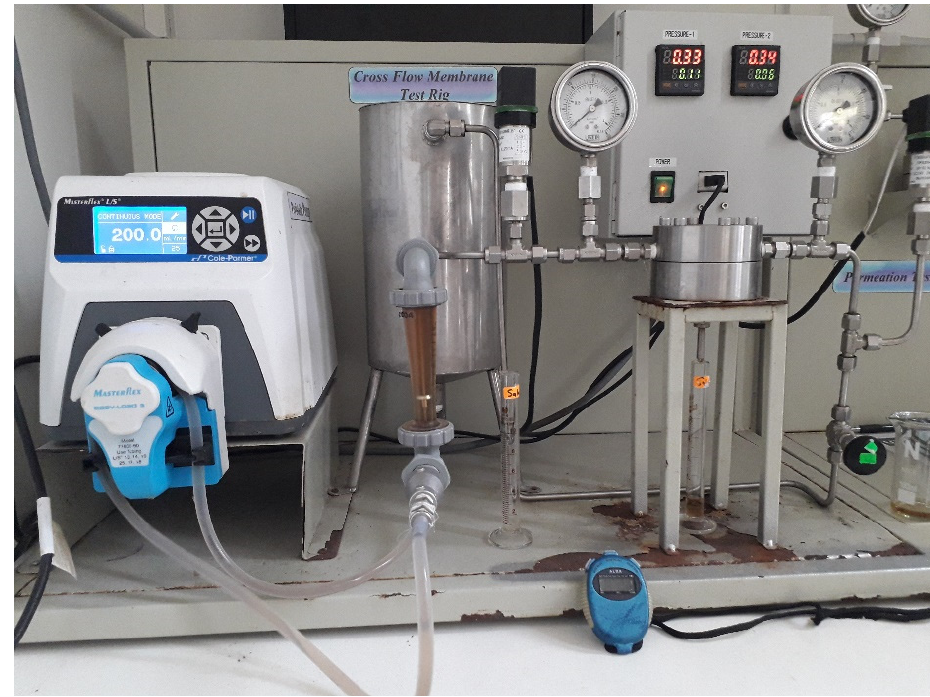
Figure 3. CFR test configuration (filtration treatment set).